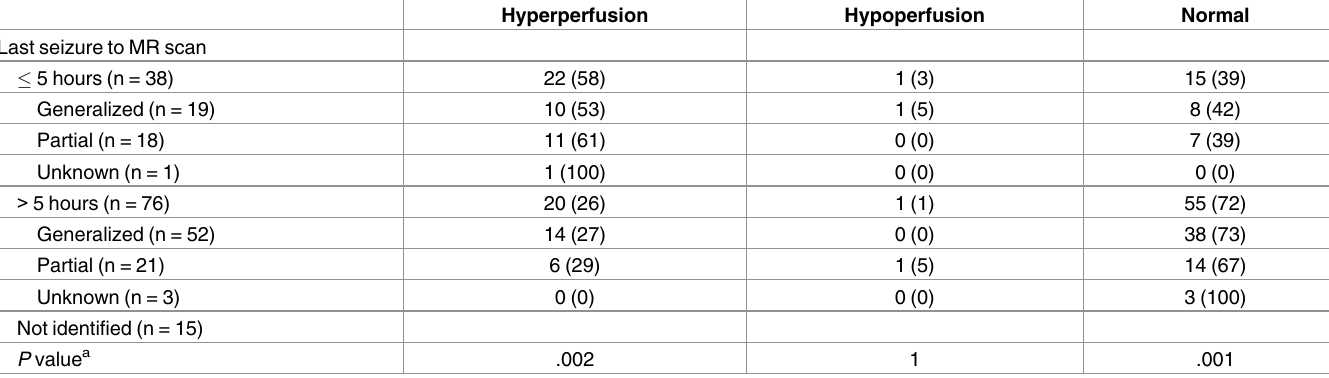
Table 3. Perfusion patterns in seizure patients (generalized vs. partial) with known time intervals between the last seizure events and MR